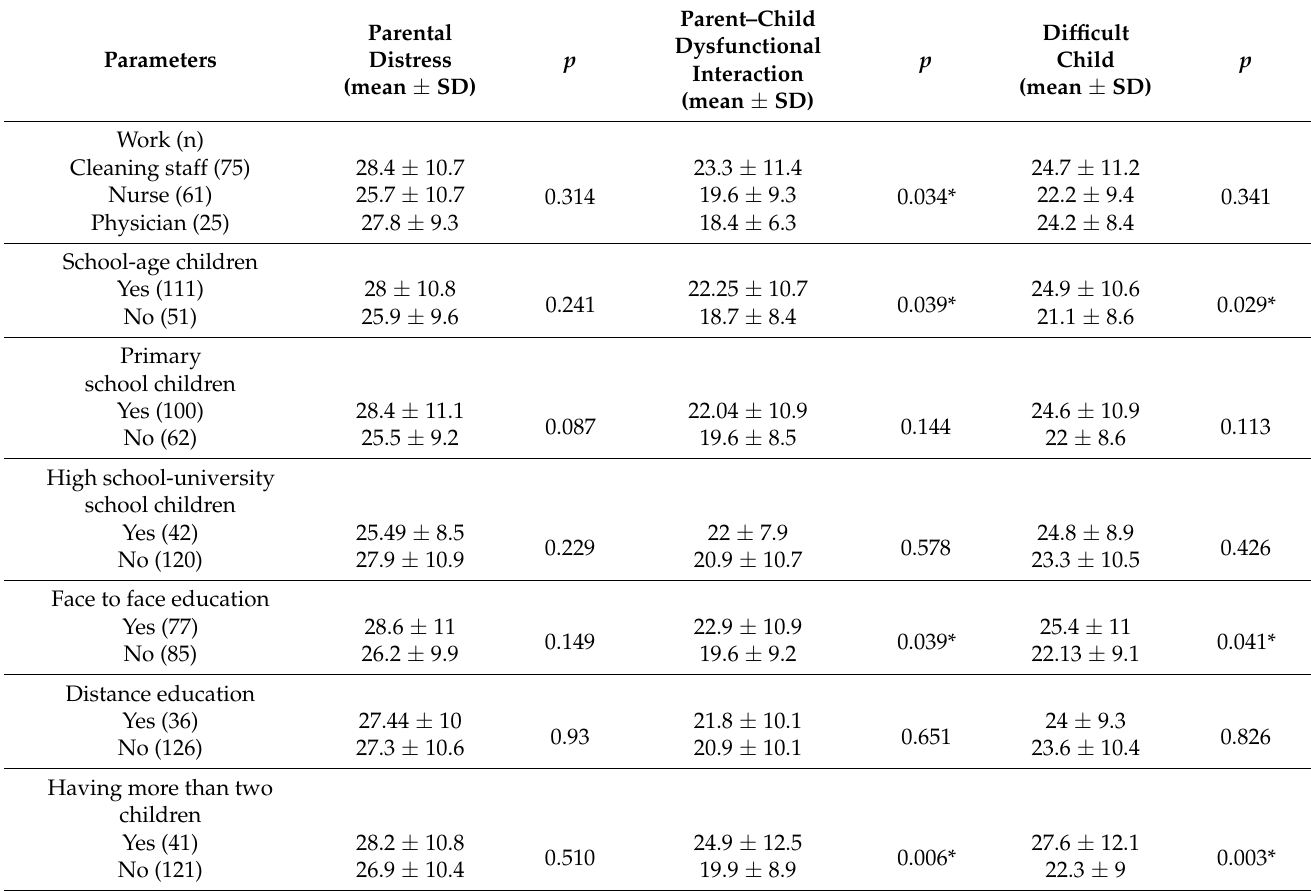
Table 5. Parameters affecting PSI-SF subscale